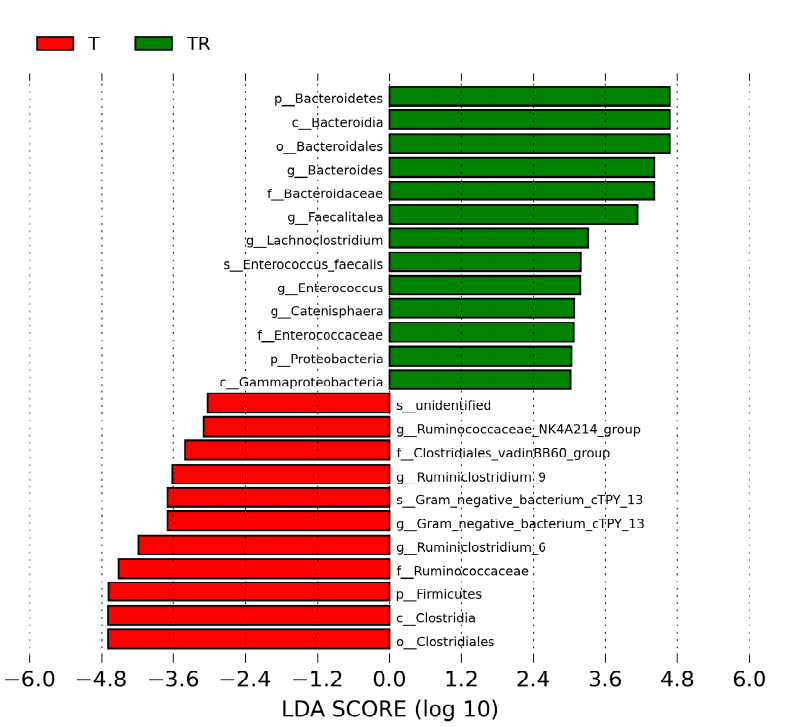
Figure 4. Effect of 2,3,7,8-tetrachlorodibenzo-p-dioxin (T) and resveratrol (R) on the gut microbiome in 12-week-old offspring. Most enriched and depleted bacterial taxa in the T (red) versus TR group (green) measured by linear discriminant analysis effect size (LEfSe) are shown. The threshold on the linear discriminant is set to 3. T = rats received weekly oral dose of TCDD 200 ng/kg for four doses; TR = rats received TCDD and resveratrol treatment.